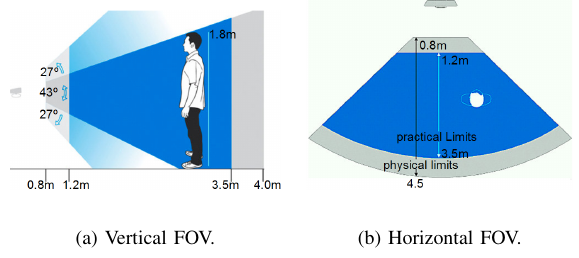
Fig. 7: In (a) and (b), the Kinect vertical and horizontal FOV in default range, respectively